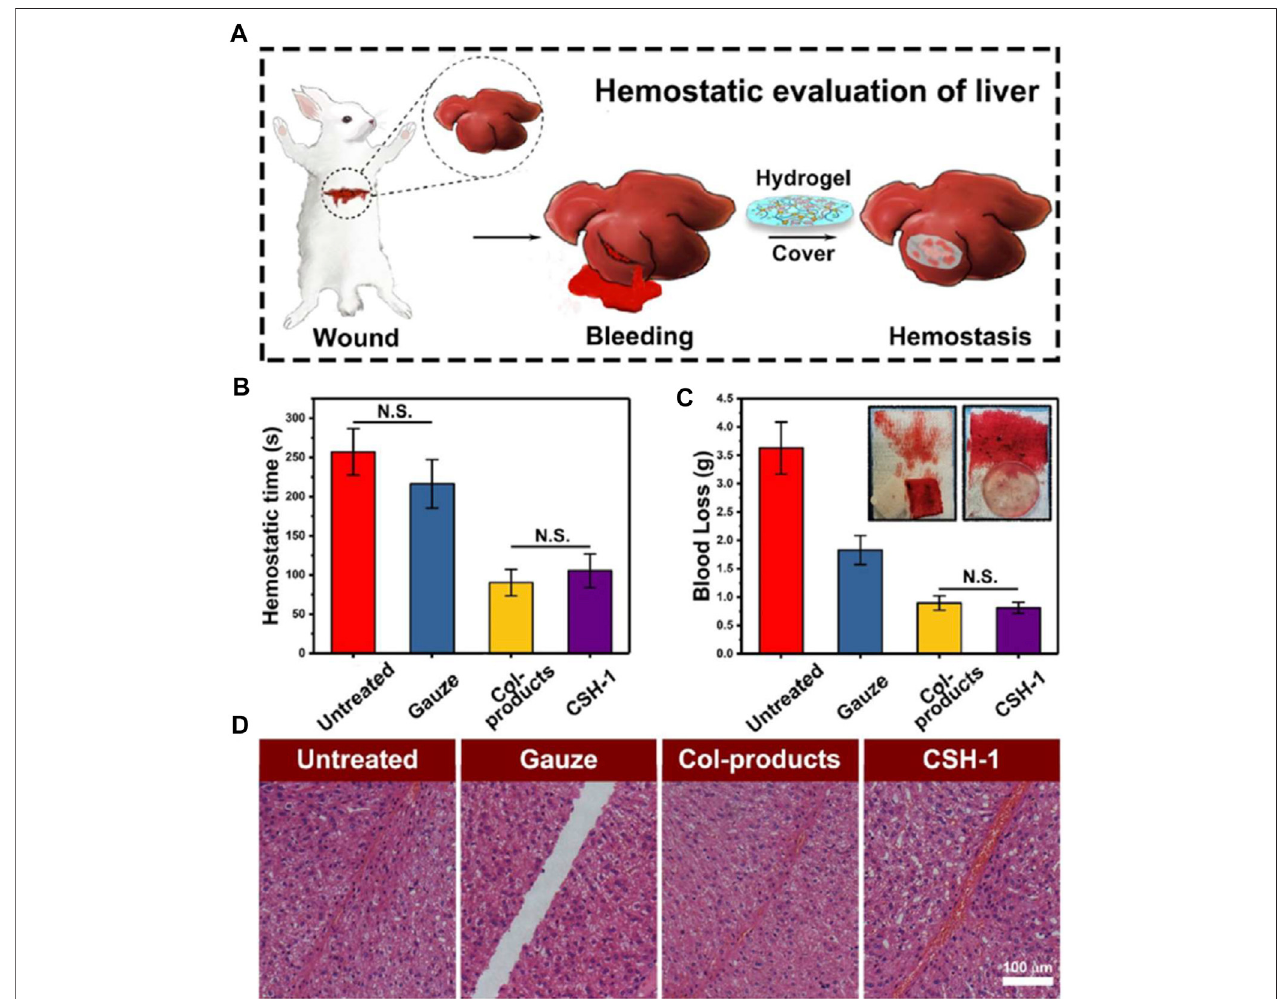
FIGURE 5 | Hemostatic evaluation of cellulose/SF hydrogels (CSHs). (A) Surgery scheme, showing that the hemostatic assay was performed with rabbit liver (rabbit experimental number (cid:1) 4). (B) Hemostatic time from the assay. (C) Blood loss assay. (D) HE staining of the incisions (the scale bar was 100 μ m), showing the CSH-1activatedhemocytes ’ aggregationinthewoundedsitesincomparisonwiththeuntreated,gauzesamples,andCol-products.Forhemostatictimeandbloodloss test, the results were calculated as mean ± SD, n (cid:1) 4. Reproduced from (Wang et al., 2020b) with permission from Copyright 2020 American Chemical Society.